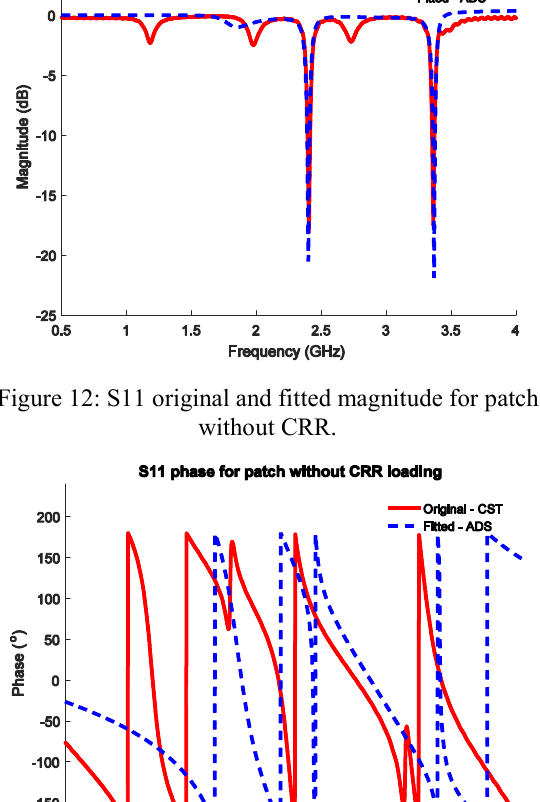
Figure 10: Radiation diagram for patch with CRR loading.